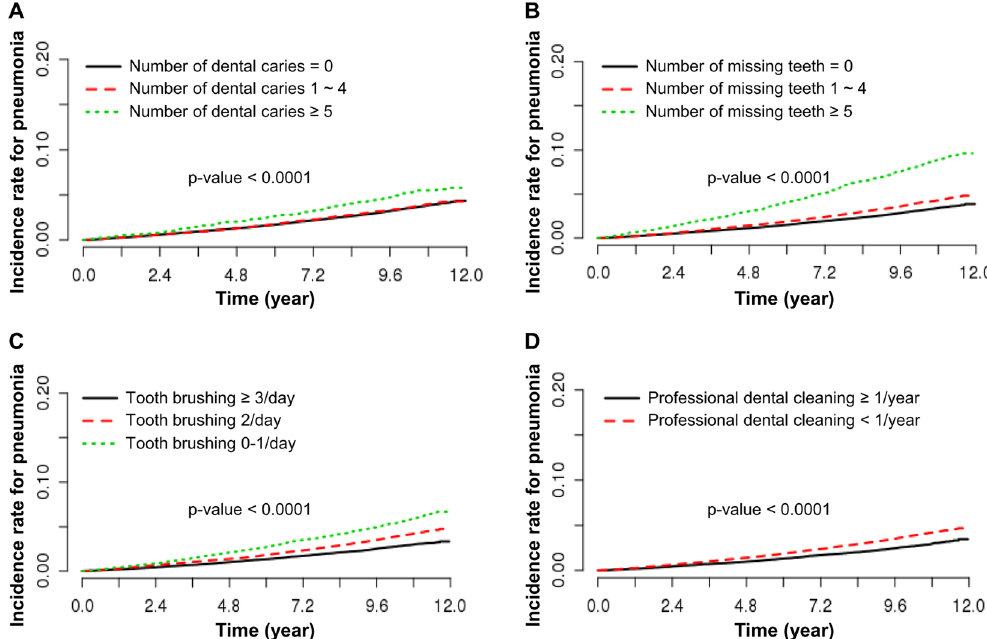
Figure 2. Kaplan-Meier curves for the incidence of pneumonia associated with oral health status and oral hygiene behaviors. ( A ) Number of dental caries, ( B ) number of missing teeth, ( C ) frequency of tooth brushing, and ( D ) frequency of professional dental cleaning. p-value for the log-rank test.